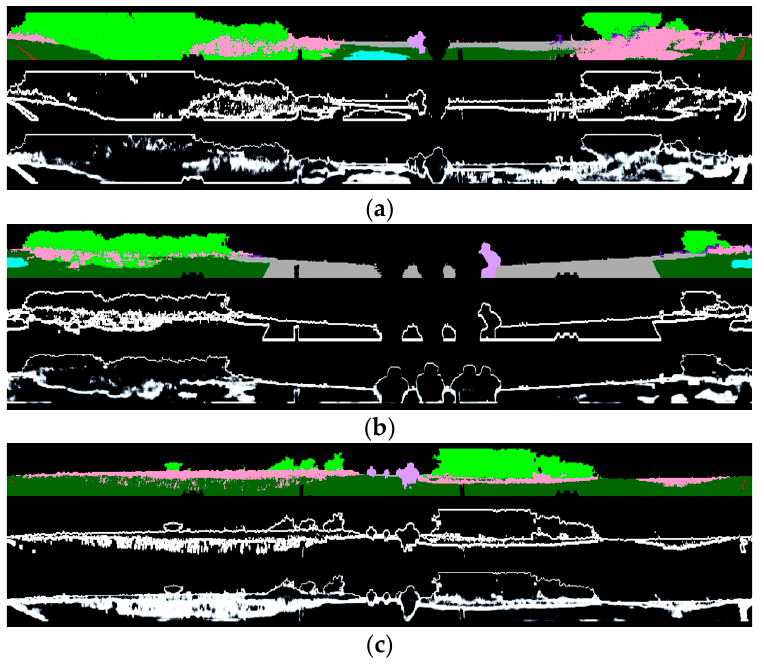
Figure A3. The inpainted GT projection image (first row), GT edge maps (second row) and predicted edge maps (third row) of samples ( a , b , c ) from Rellis-3D.